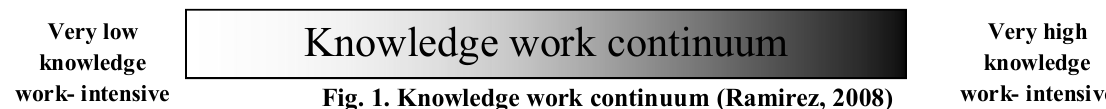
Fig. 1. Knowledge work continuum (Ramirez,